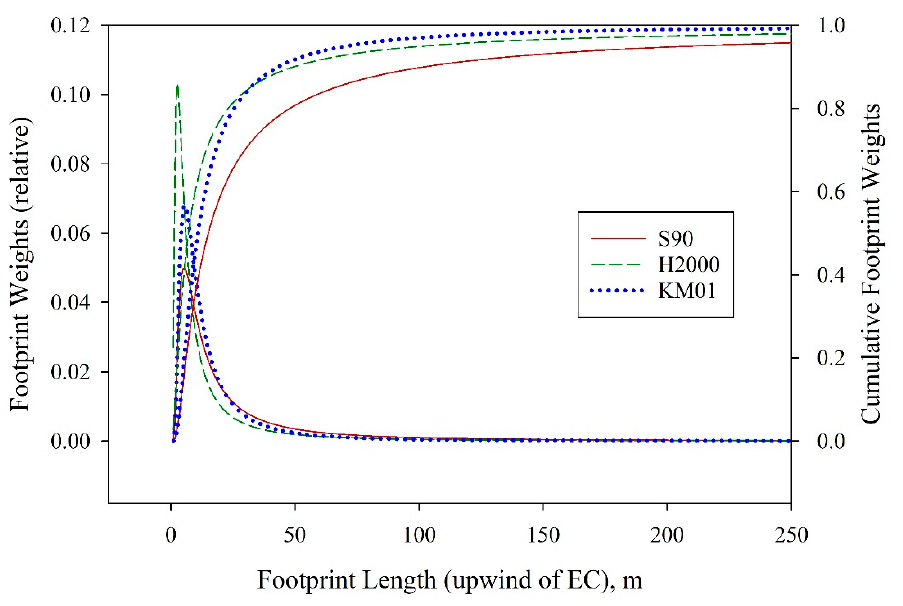
Figure 9. One dimensional plot of the footprints at EC1 using the S90, H2000, and KM01 models during unstable stratification on DOY 195 at 14:30 am CST.